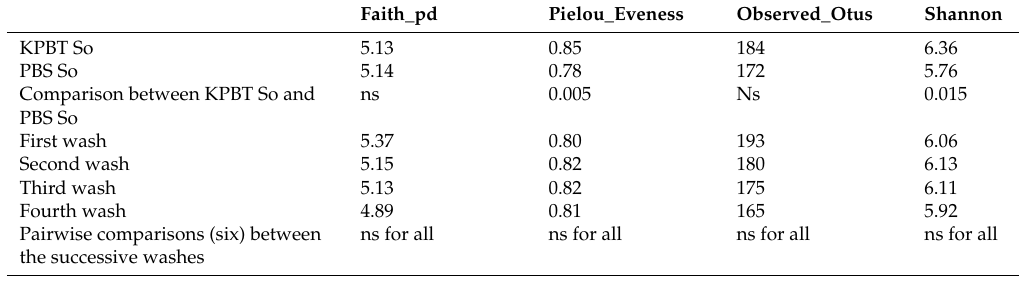
Table 3. Alpha-diversity comparisons (pairwise Kruskal–Wallis, q -value) between the protocols, between successive washes before pooling of washes and after the pooling of washes of apple fruit carposphere; ns = not statistically significant; pd = phylogenetic diversity; So = sonication. All the successive washes were pairwise compared. Faith_pd Pielou_Eveness Observed_Otus Shannon 5.13 0.85 184 6.36 PBS So 5.14 0.78 172 5.76 Comparison between KPBT So